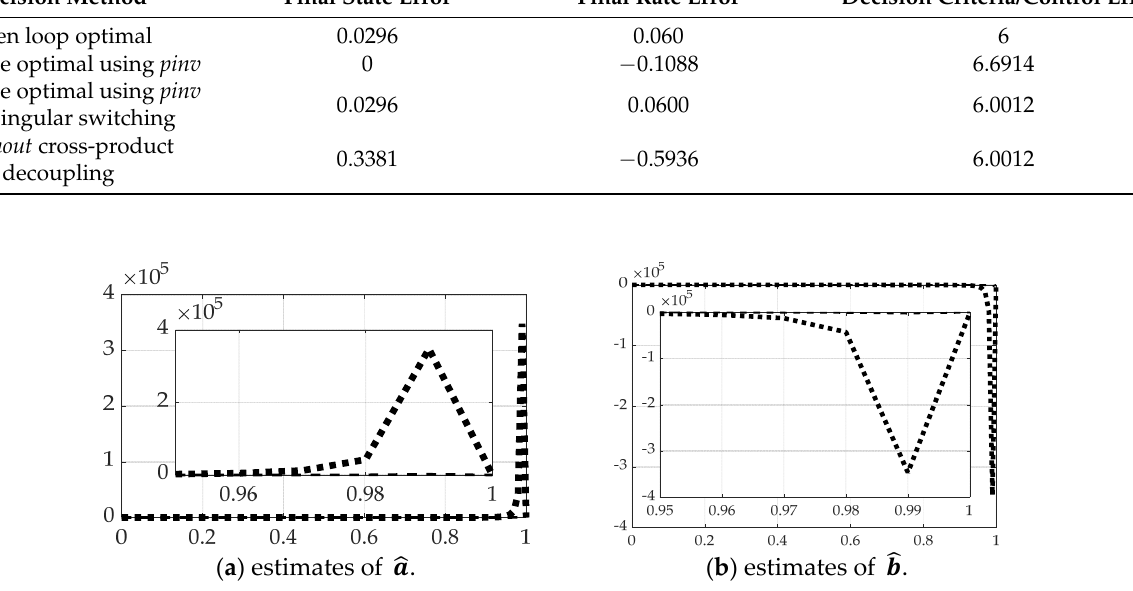
Figure 10. Comparison of real-time optimal methods with scaled time on the abscissae and respective ordinates titled in the subplot captions: dashed line is real-time optimal using backslash, dotted line is real-time optimal using pinv with singular switching. ( a ) Estimates of ˆ a , ( b ) estimates of ˆ b . The ranges of the zoomed view in the inset are indicated by the respective scales.